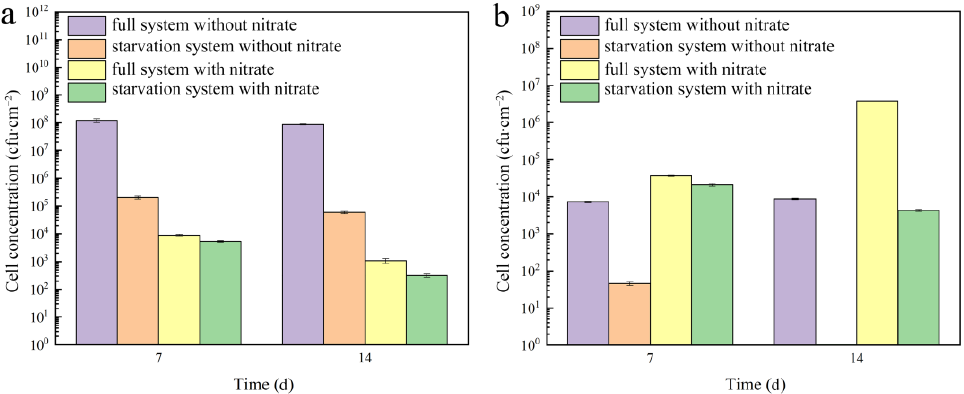
Figure 1. The sessile cell numbers of D. vulgaris ( a ) and P. aeruginosa ( b ) in different systems. The CLSM images of biofilms on coupons exposed to different systems are shown in Figure 2. In the full system without nitrate addition, a high intensity of green fluorescence was observed on the 7th day, which is consistent with the 10 8 cfu∙c m −2 sessile cell number of D. vulgaris in Figure 1. On the 14th day, the color of the biofilm changed to yellow,